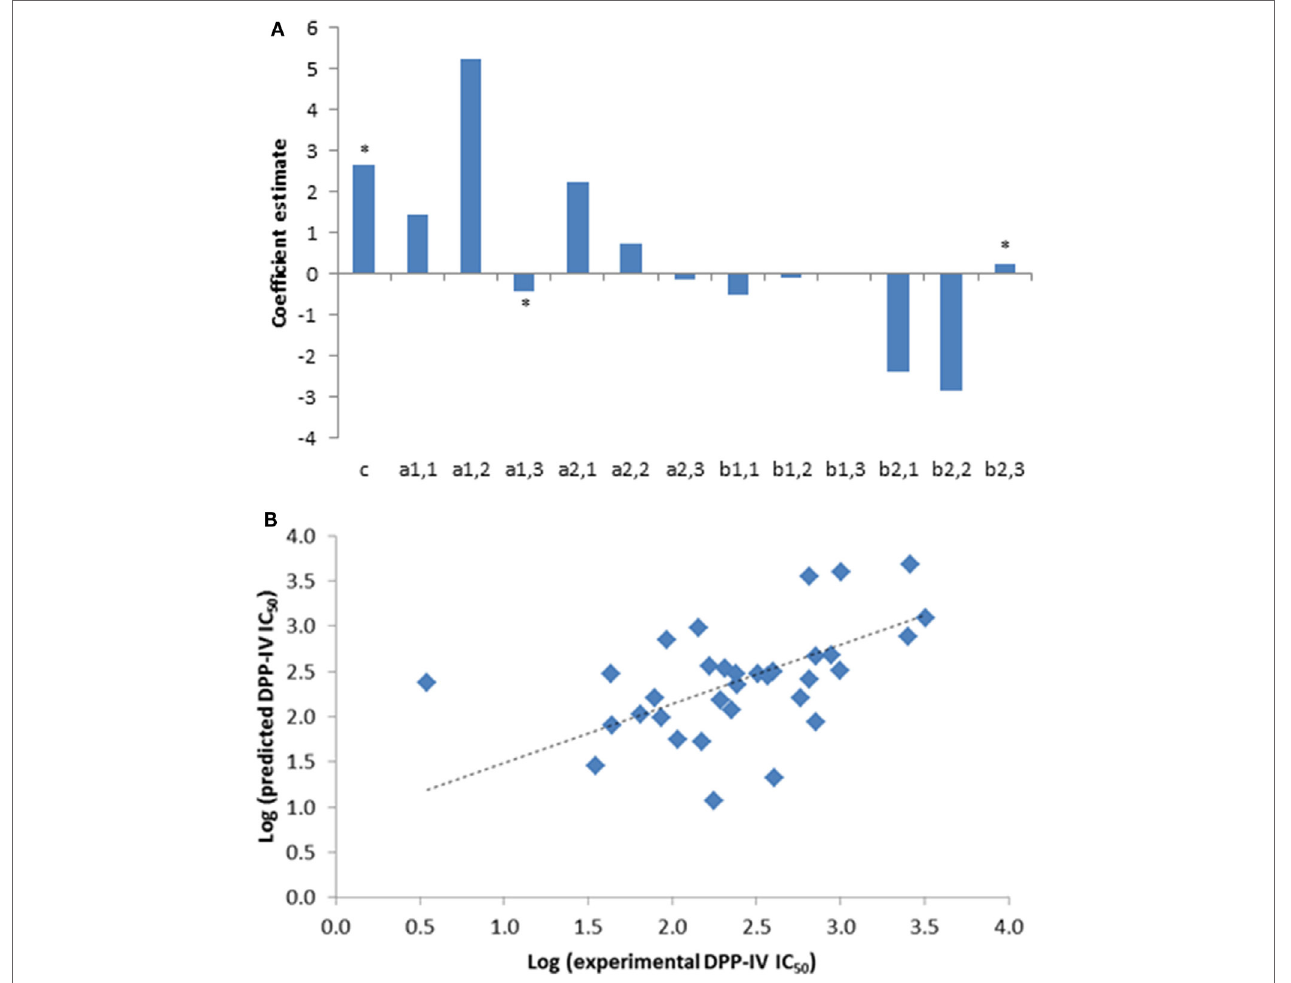
FigUre 1 | (a) Coefficients of the partial least squares regression (PLSR) linking the dipeptidyl peptidase IV (DPP-IV) half maximal inhibitory concentration (IC 50 ) of the peptides used to generate the quantitative structure activity relationship (QSAR) model (Eq. 1). *Coefficients with a p < 0.05 are significantly different from 0. (b) Predicted DPP-IV IC 50 value of the peptides used to build the QSAR model ( Table 1 ) as a function of the experimental DPP-IV IC 50 value, the line represents the QSAR model (Eq.